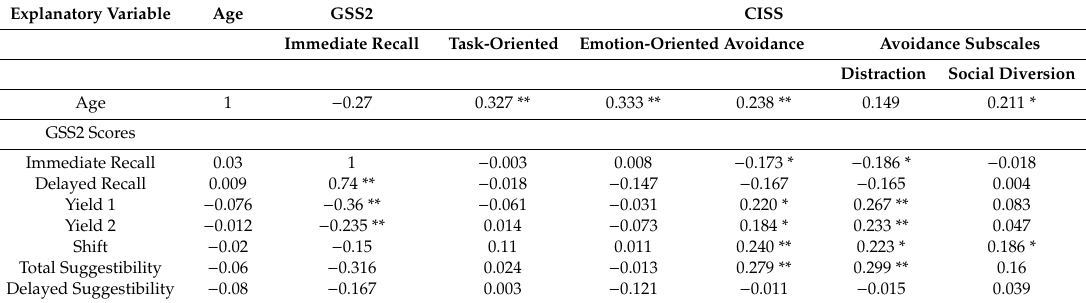
Table 2. Pearson’s correlation between the GSS2 and CISS ( n =